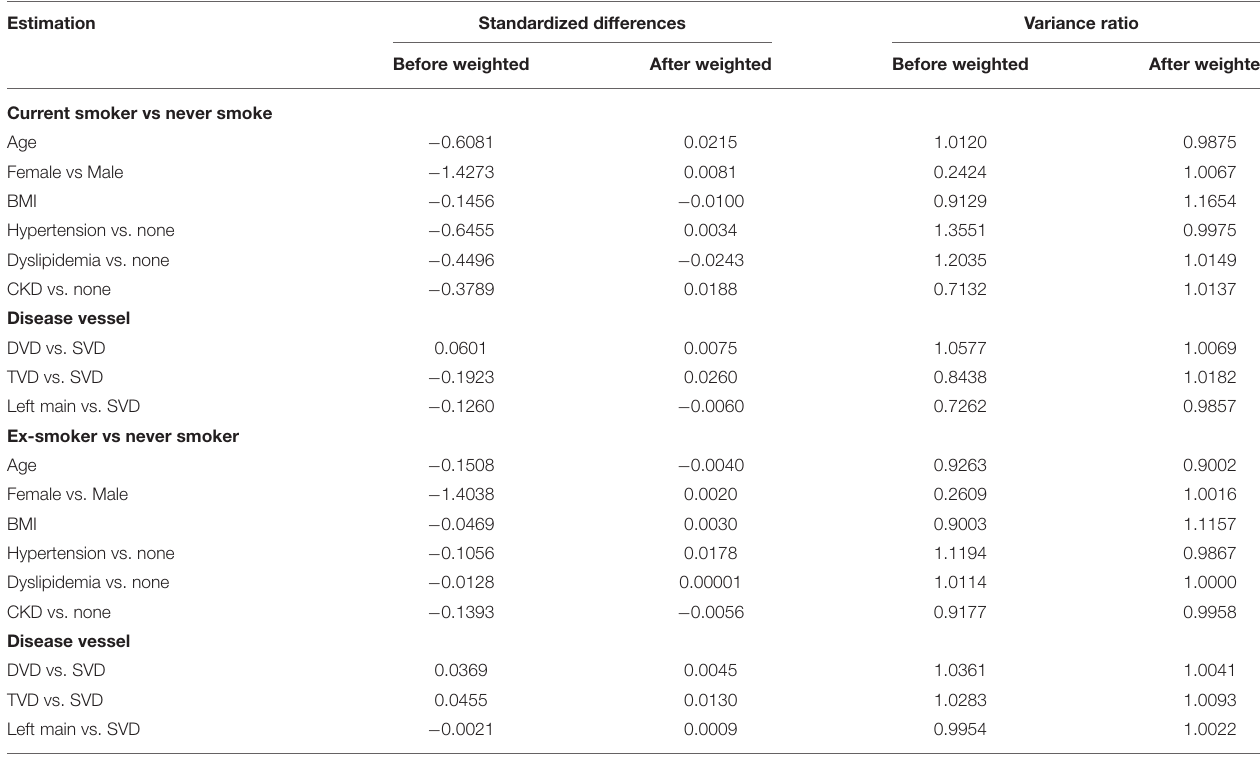
TABLE 3 | Balance of factors associated with smoking status. Estimation Standardized differences